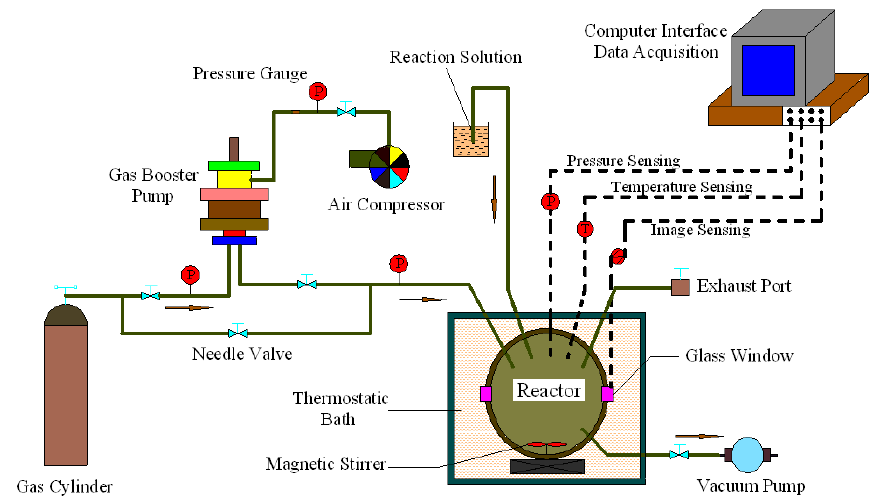
Figure 1. Schematic diagram of experimental apparatus.